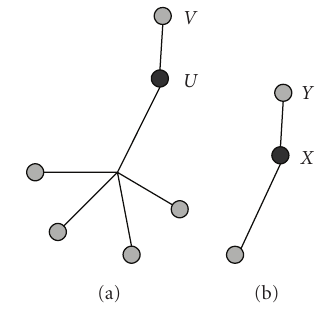
Figure 8: Multipin net (a) versus two pin net (b) [15]. Placement tools do not treat these two nets the same way causing small fan- out nets having stronger contraction compared to larger fan-out ones which results in the connection ( U , V ) to be shorter than connection ( X , Y )